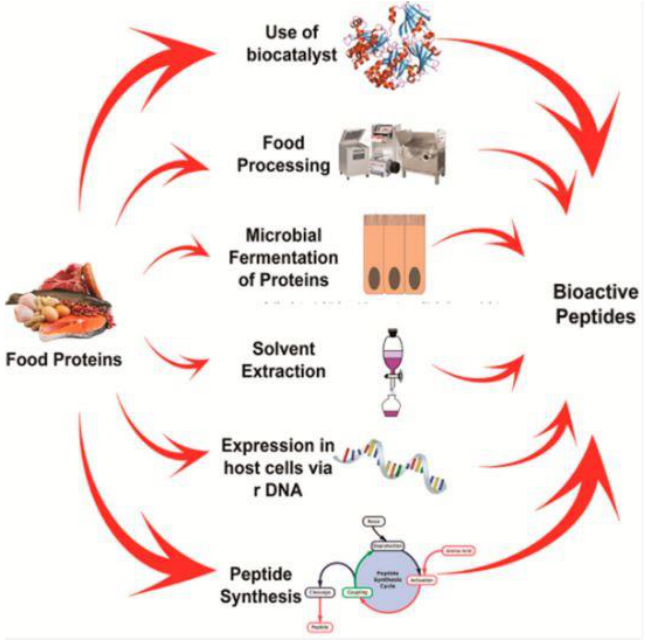
Figure 1. Various methods used to extract and form proteins/peptides. Reproduced with permission from Chelliah et al. (2021), © MDPI, 2021 [48].